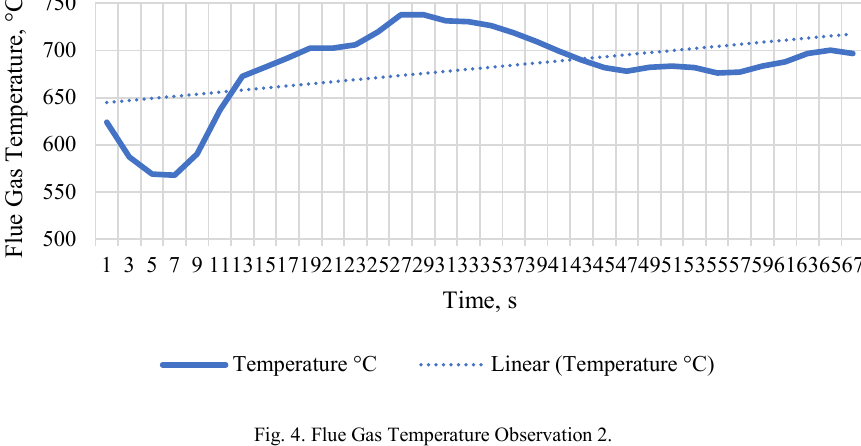
Fig. 4. Flue Gas Temperature Observation 2.